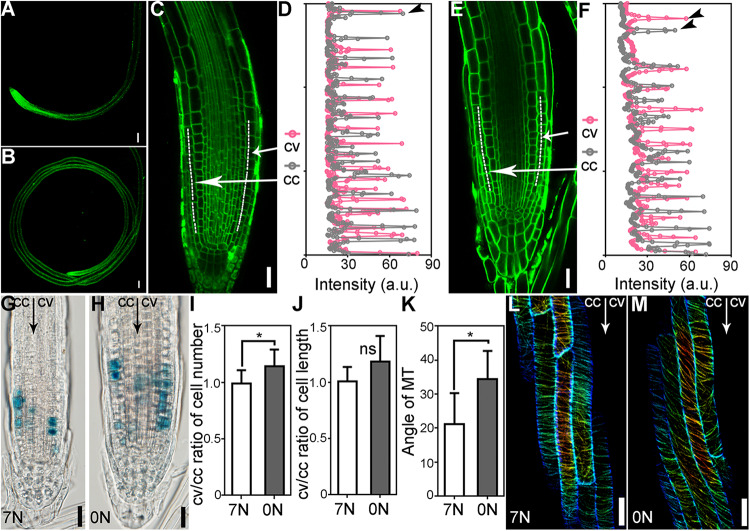
Nitrate deficiency-induced ARG results from unequal cell division and elongation. (A,B) A primary root on 7N (A) or 0N medium (B). FM4-64 staining (green) was used to show cell silhouettes. (C–F) Representative root meristem zone on 7N (C,D) or 0N (E,F). Confocal laser scanning micrographs (CLSM) are shown in (C,E). Signal intensity of the dotted lines across 14 epidermal cells either from the convex side (cv) or the concave side (cc) in (C,E) is shown in (D,F), respectively. Peaks in (D,F) indicate the plasma membrane (PM) of cells. The distance between two neighboring peaks of the same color indicates the length of a cell. (G,H) Representative histochemical GUS staining of ProCYCB:GUS roots growing on 7N (G) or on 0N medium (H). All 15 roots examined for each treatment (7N or 0N) showed similar results. (I,J) Ratio of cv/cc cell numbers (I) or length (J). Only cells at the elongation zone were measured. (K) Angle of MT to the transverse plane of root growth axis. Results shown in (I–K) are means ± SE. Three independent experiments involving 30 roots in each treatment were conducted. Asterisks indicate significant difference (t-test, P < 0.05). ns indicates no significant difference (t-test, P > 0.05). (L,M) CLSM of a primary root from the Pro35S:GFP-MAP4BD transgenic plants on 7N (L) or 0N medium (M) 8 h after being placed horizontally. Bars = 100 μm for (A,B), 20 μm for (C,E,G,H,L,M).